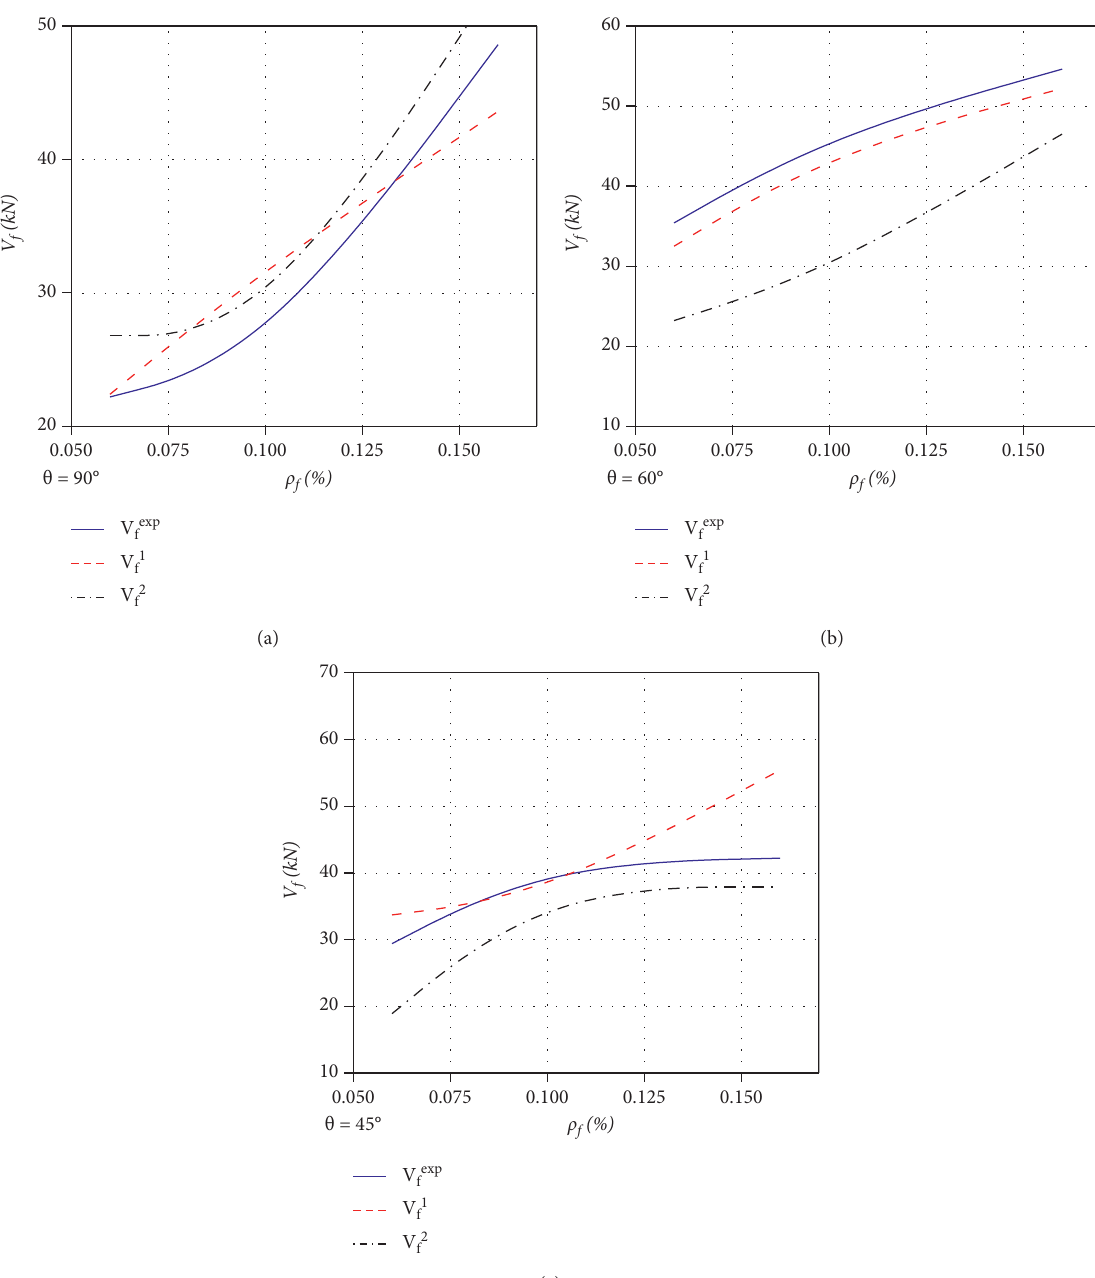
Figure 7: Effect of the percentage of the FRP for different reinforcement inclination angles on the contribution of the NSM FRP shear strengthening technique (the experimental FRP contribution gained from